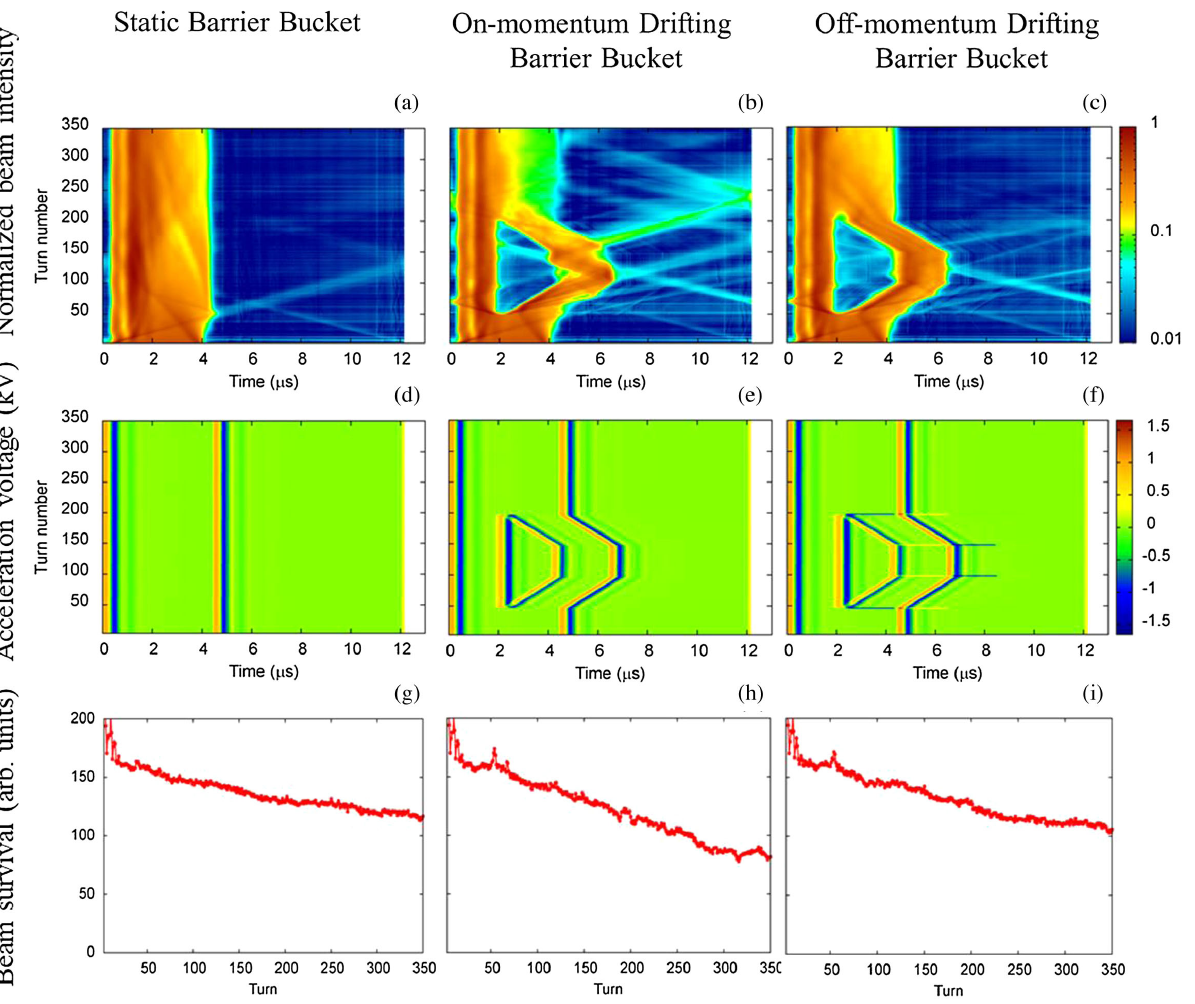
FIG. 3. Comparison of (top) beam intensities, (middle) acceleration voltages, and (bottom) beam survival for the SBB (left column), onDBB (middle column), and offDBB (right column) in the experiments. In the color-coded plots (a) – (f), the horizontal and vertical axes indicate the inner time in one revolution period and the turn number after the injection, respectively. In the plots (g) – (i), the horizontal and vertical axes denote the turn number after the injection and the beam survival in arbitrary units,